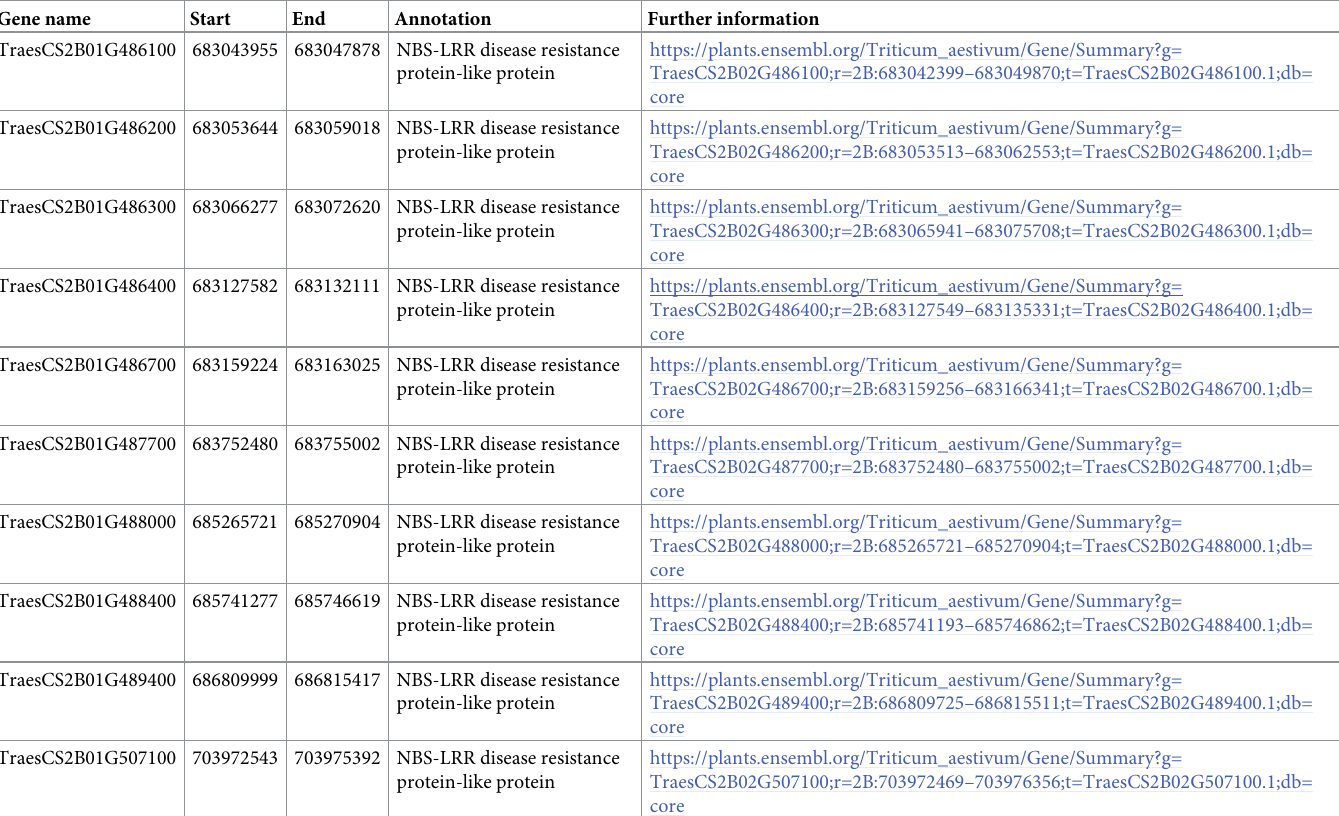
Table 2. Candidate genes. Annotated disease resistance genes within the candidate intervals of 633,430,001–663,920,001bp, 681,790,001–693,030,001bp and 702,660,001–721,190,001bp on RefSeqv1 chromosome 2B. Gene